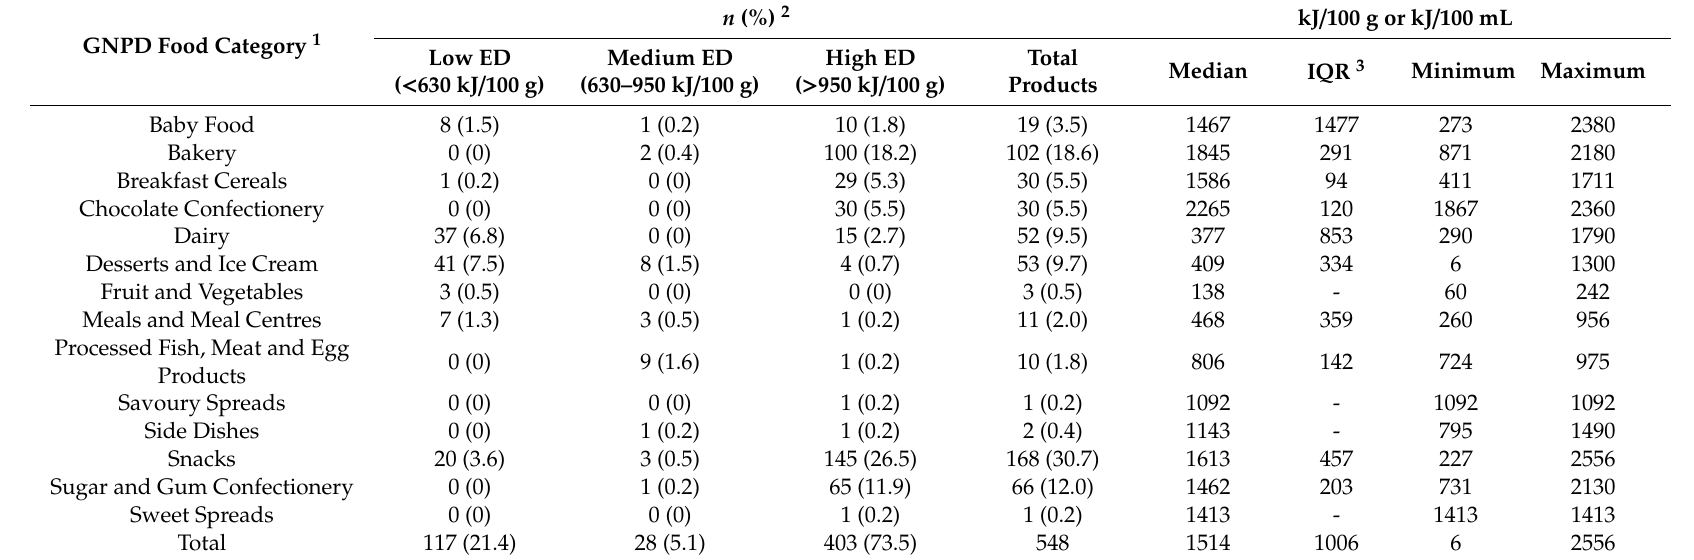
Table 1. Numbers of products in each Global New Products Database (GNPD) food category classified as low, medium and high energy density (ED) and median ED for each GNPD food